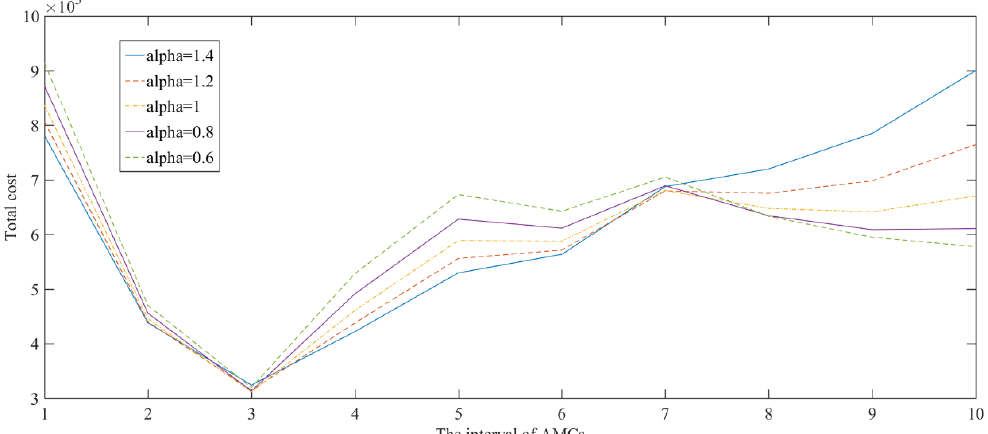
Figure 6. Expected total cost C vs. A for M m = 10 6 , M C A 2 = 0.04, C P = 7, as well as for different values of α